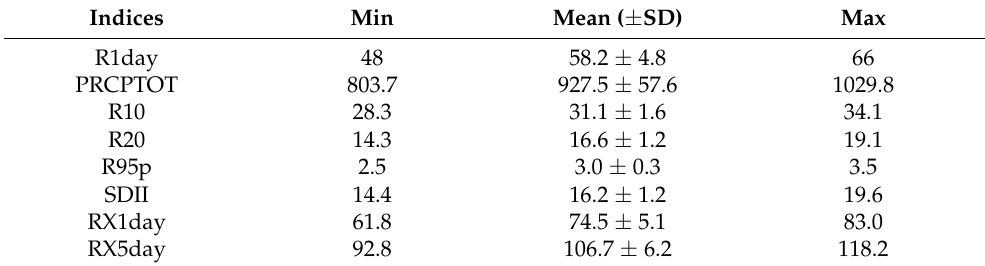
Table 3. Climatology (normal) precipitation characteristics are given by minimum (Min), average (Mean), standard deviation (SD), and maximum (Max). Min, mean, SD, and max of a given index provide climatological precipitation of the corresponding index at the study area level. Indices Min Mean ( ± SD)